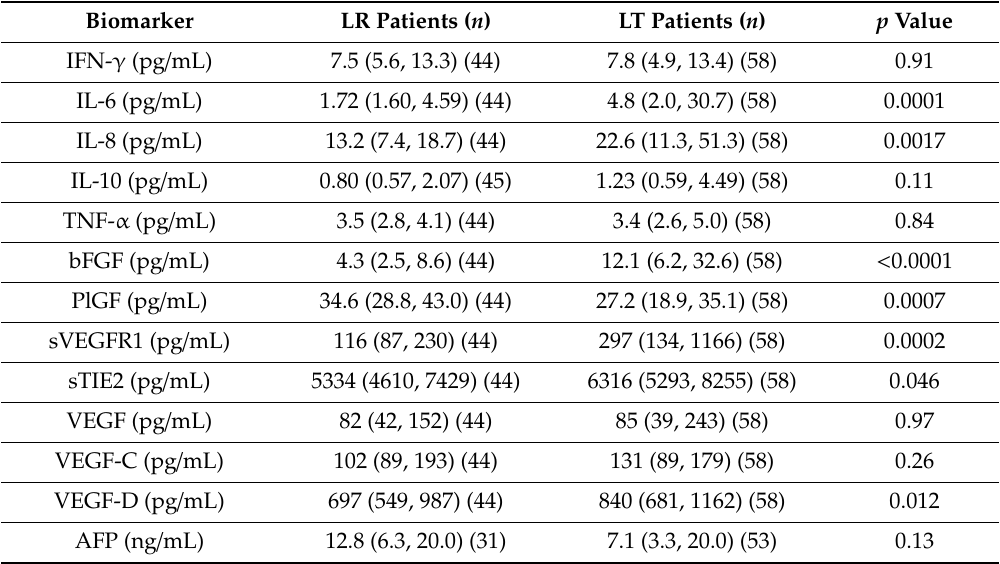
Table 2. Pre-operative plasma biomarkers in hepatocellular carcinoma patients who underwent liver resection (LR) and liver transplantation (LT). Data are shown as median values and interquartile ranges, with p values from the Wilcoxon / Fisher’s exact